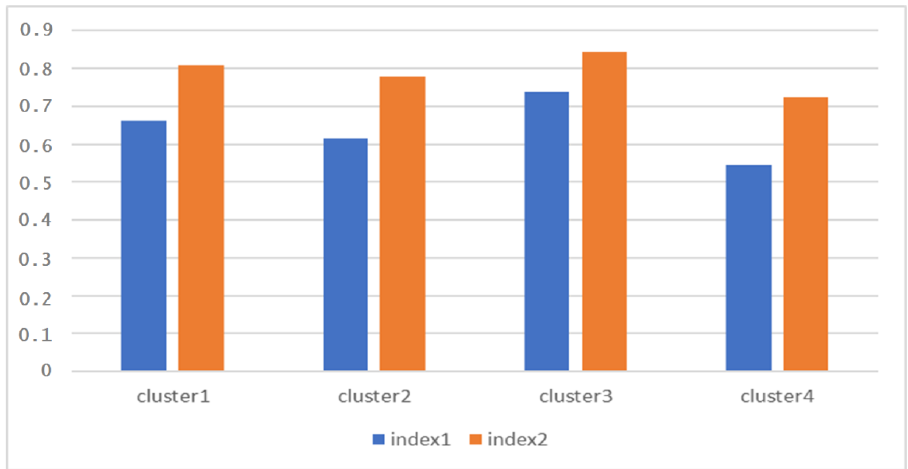
Figure 7. Rate of the circular values in the different clusters: Index 1 is a ratio for direct food purchasing.